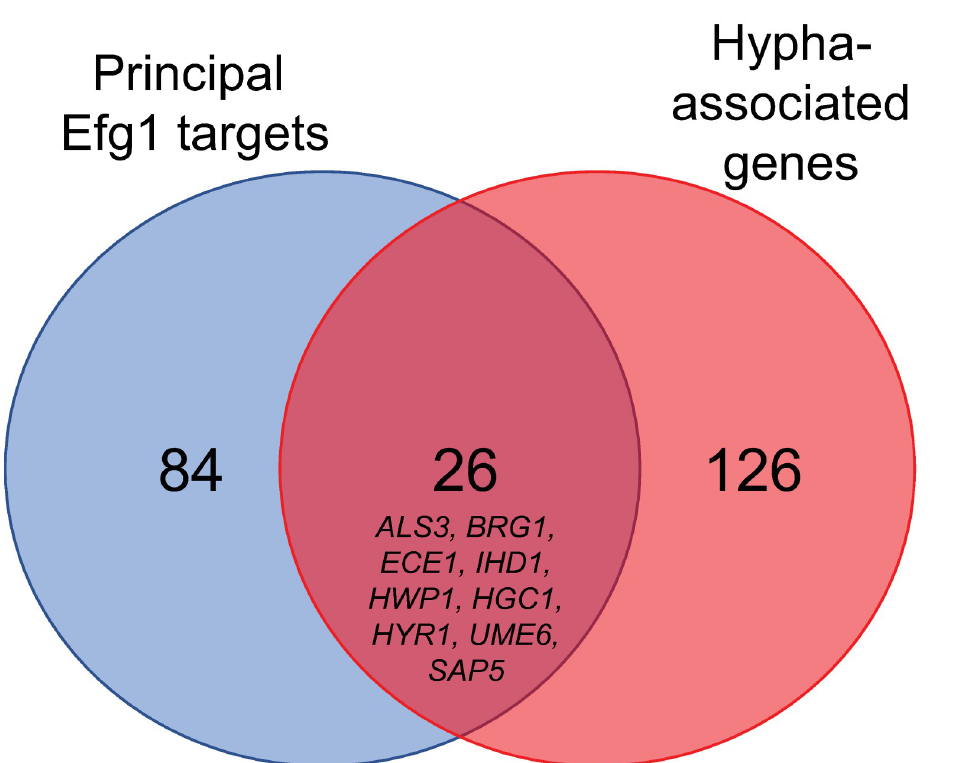
Fig 3. Relationship between the principal EFG1 targets and the clinical isolate-derived hypha-associated gene set. Well studied hypha-associated genes including ALS3 , BRG1 , ECE1 , IHD1 , HWP1 , HGC1 , HYR1 , UME6 , and SAP5 are included in both gene